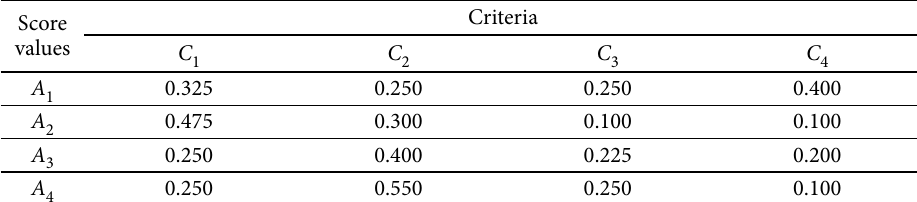
Table 2. The score values of ij s Score values